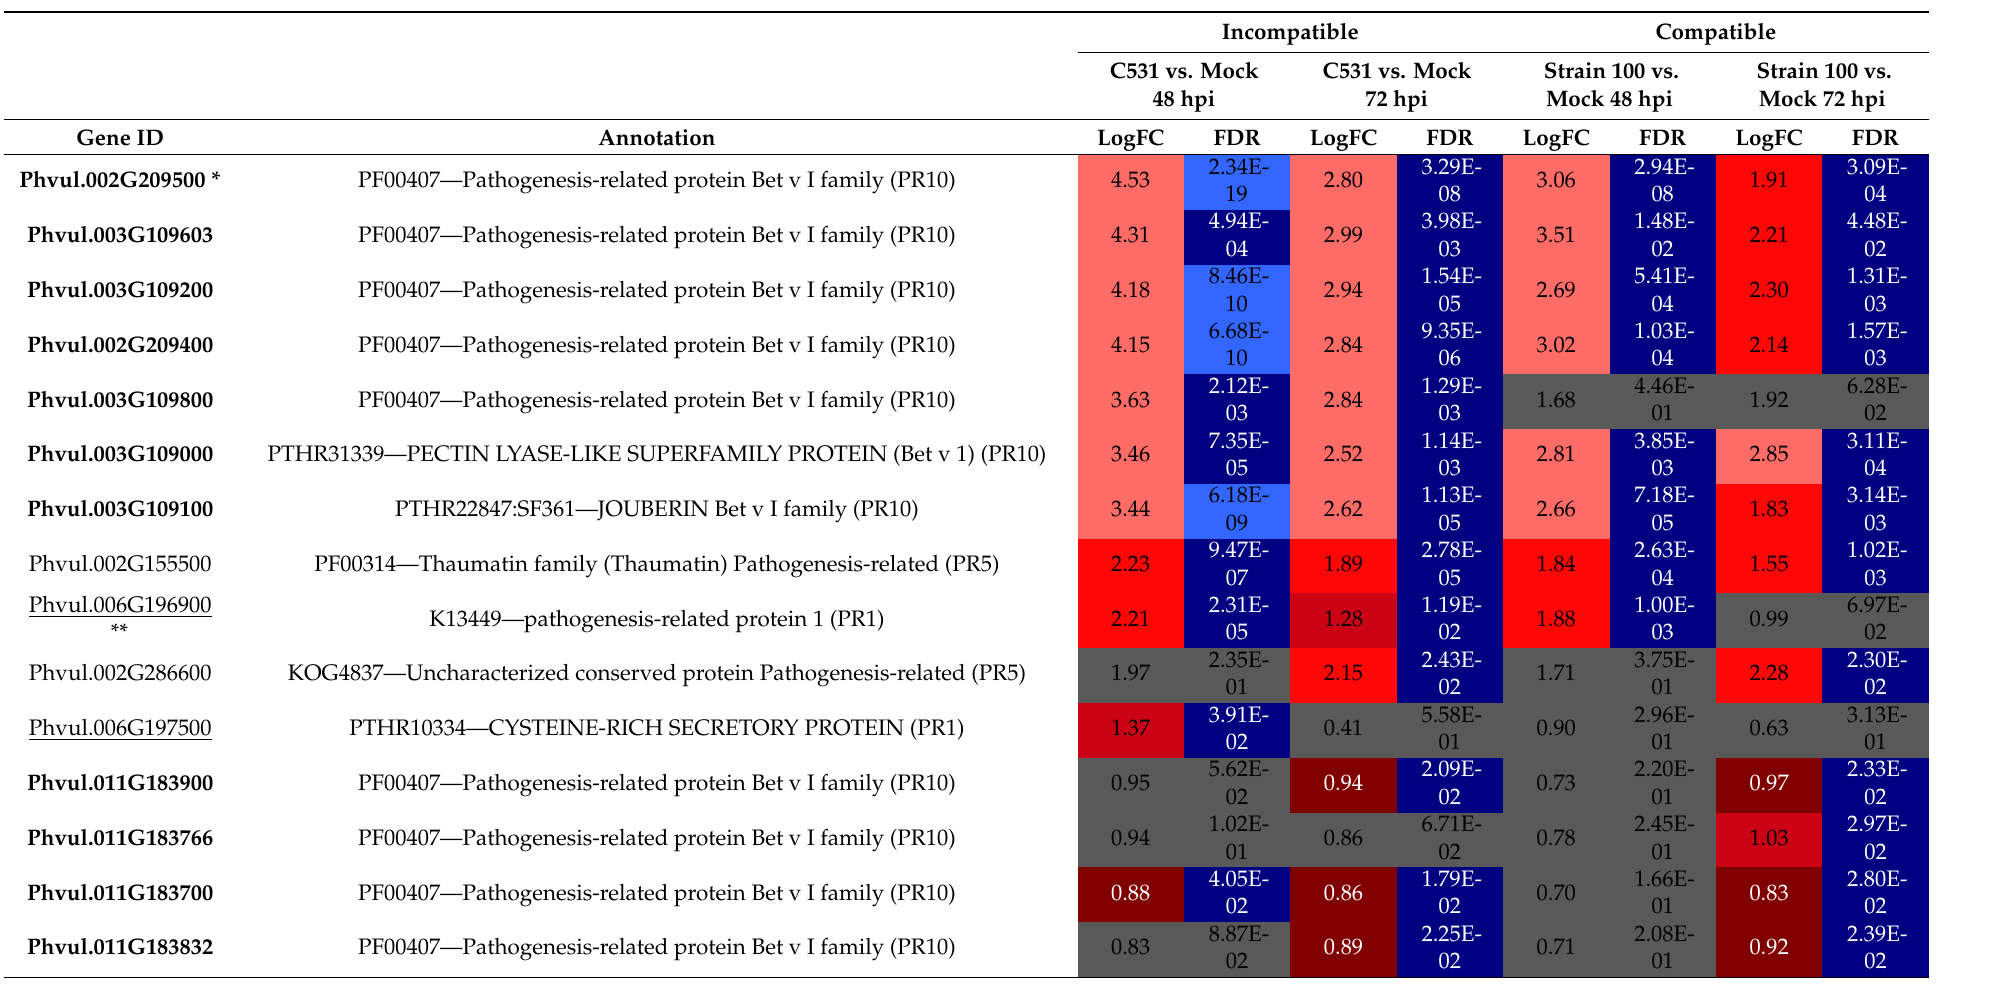
Table 2. List of significantly differentially expressed pathogenesis-related proteins (PRs) in compatible and incompatible interaction, at 48 hpi and 72 hpi.